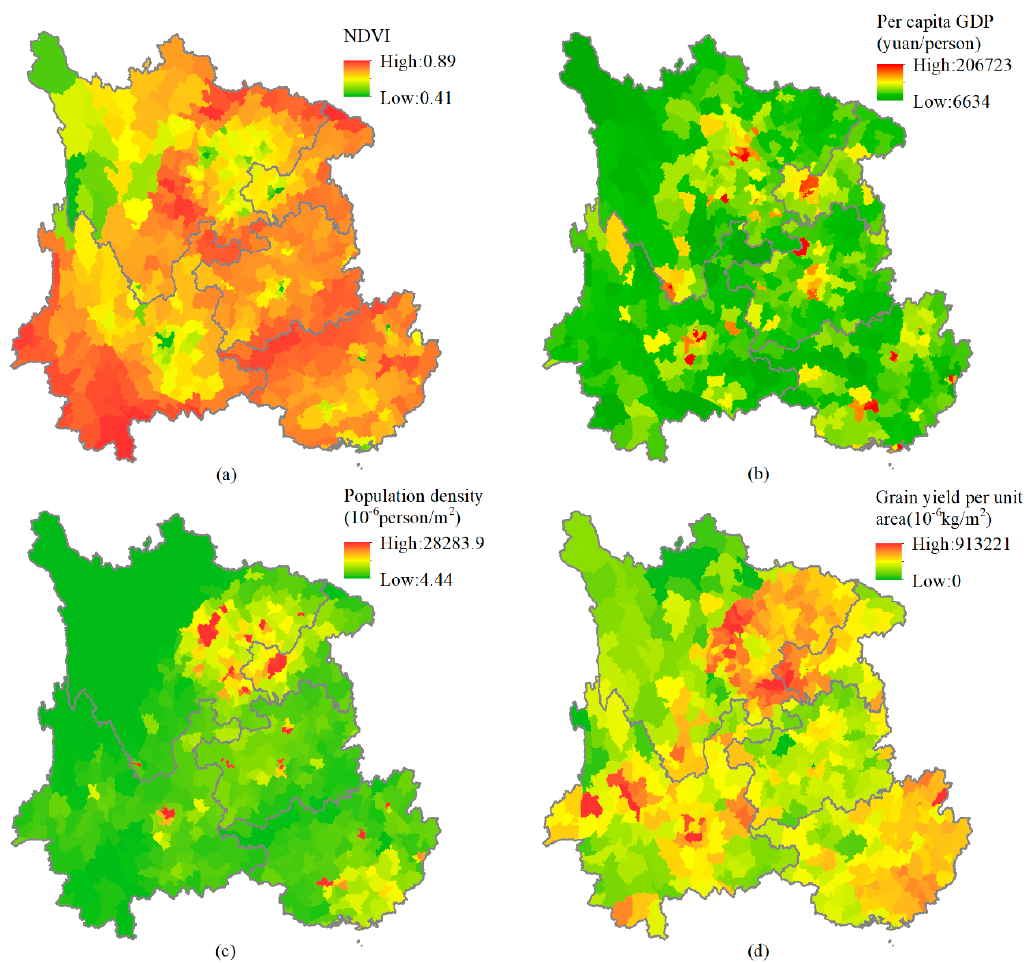
Figure 5. The spatial distribution of different eco-socio-economic water demand elements at the county level: ( a ) Normalized difference vegetation index (NDVI), ( b ) per capita GDP, ( c ) population density, ( d ) grain yield per unit area.